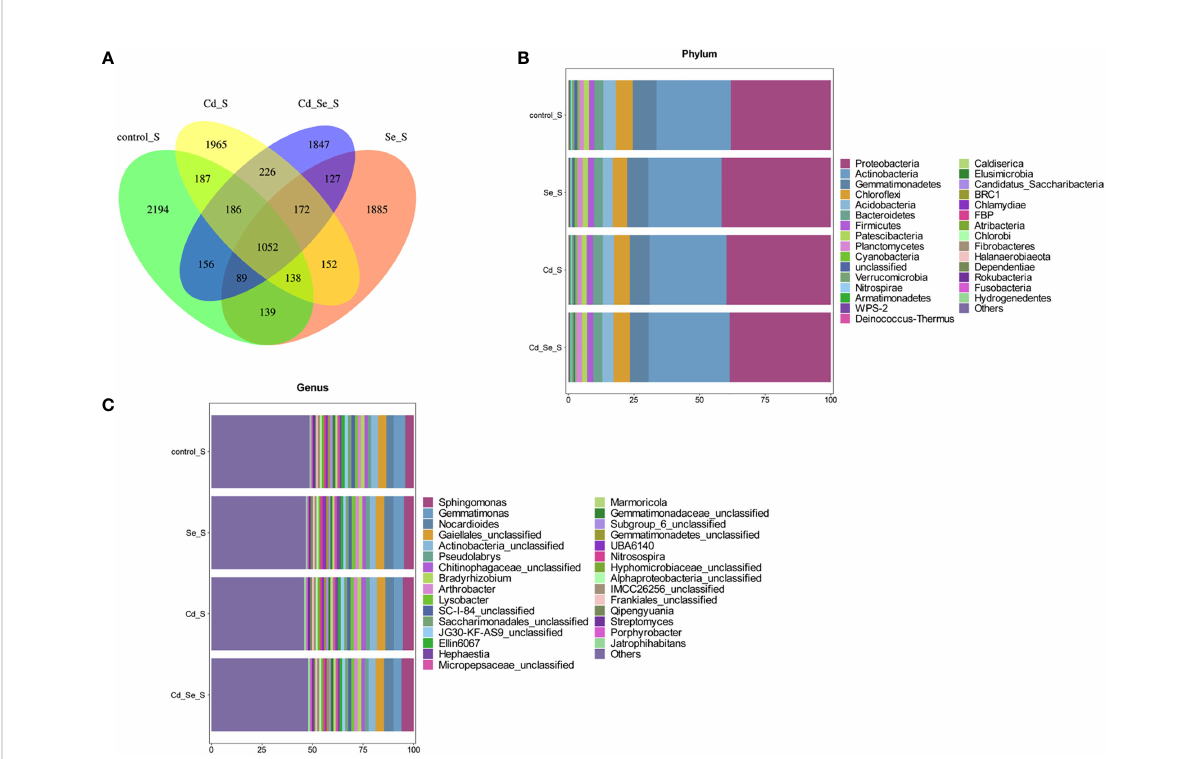
FIGURE 5 Effects of root exposure to Se (1.2 mg/kg) on non-rhizosphere soil microbial community structure in perilla under Cd stress (10 mg/kg). (A) Venn plot; (B) Histogram of species abundance at phylum level; (C) Histogram of species abundance at genera